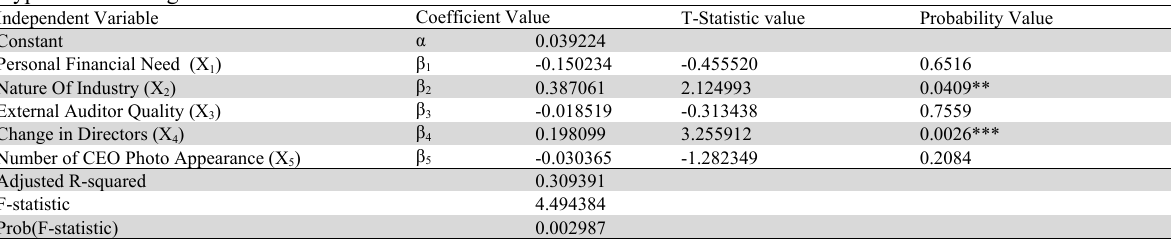
Hypothesis Testing Results with the Common Effect Model Independent